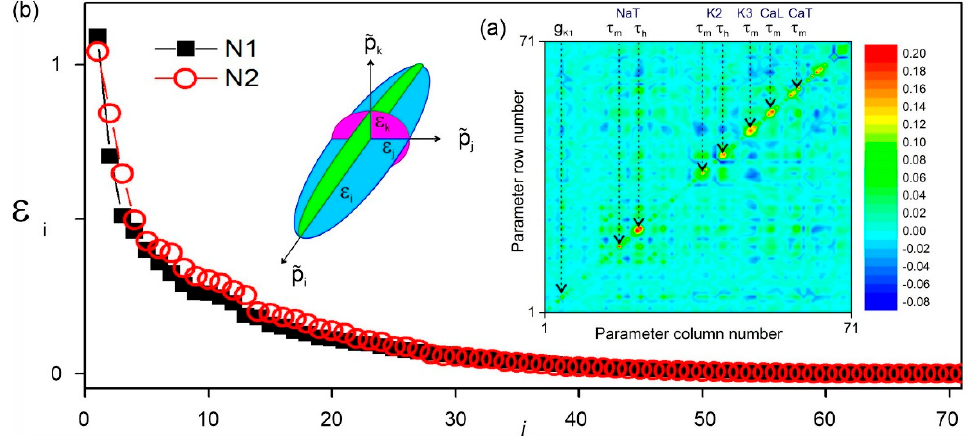
Figure 5. Correlations between estimated parameters. ( a ) Covariance matrix of the 71 parameters of a multichannel conductance models, synchronized to electrophysiological recordings of a songbird neuron. A total of 81 sets of parameters were estimated from different assimilation windows to generate the statistical sample used to compute the covariance. Parameters pertaining to each ion channel tend to be more correlated. The greater error/variance is in the recovery time constants of ionic gates ( τ m , τ h ). The principal values of the covariance matrix give the length of the principal semi- axes of the data misfit ellipsoid δ c = kT . ( b ) Spectrum of principal values of the covariance